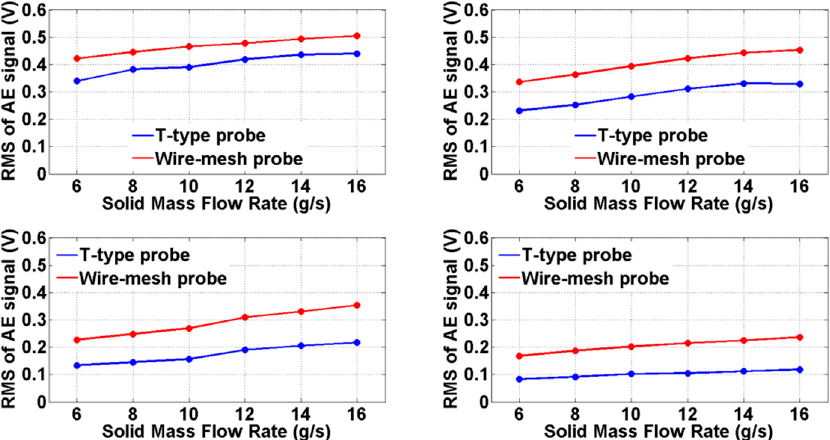
Figure 8. The RMS average values of the AE signals with respect to particle mass flow rate at four different particle sizes.